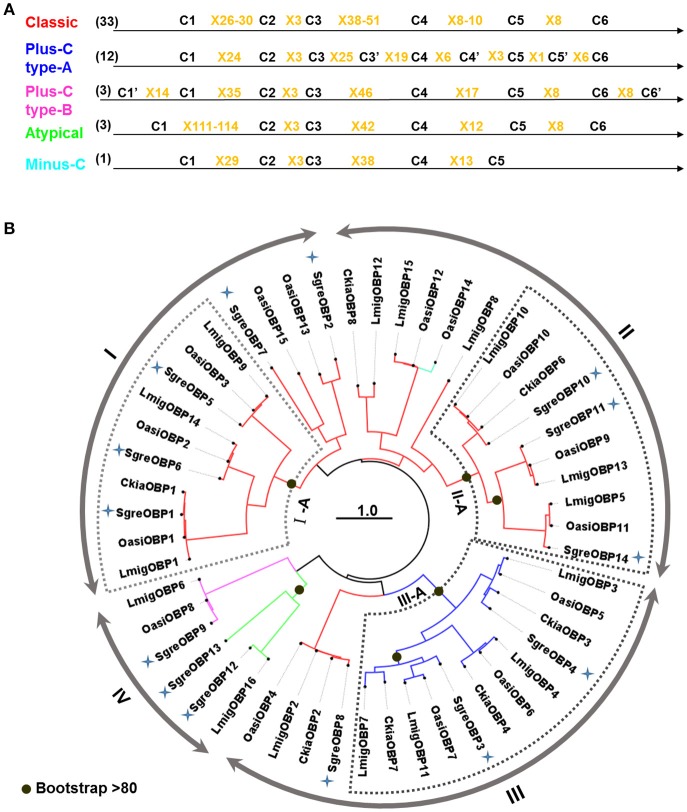
C-residue skeletons and phylogeny of OBPs from four locust species. (A) OBPs subtypes were categorized based on the number of conserved C-residues. C-skeleton patterns are based on the multiple sequence alignment of 52 OBP sequences from four locust species. C-residues conserved in all OBPs are shown as C1-C6 in black characters; additional C-residues conserved in the two plus-C OBP types are shown as C'; amino acid between two C-residues are shown as X plus the number of amino acid. The number of each OBP subtype is given in the parenthesis. (B) The phylogenetic tree was constructed using the maximum likelihood algorithm supported by 1,000 bootstrap replicates. OBP sequences utilized to generate the tree were derived from four locust species: 14 from Schistocerca gregaria (SgreOBPs), 16 from Locusta migratoria (LmigOBPs), 15 from Oedaleus asiaticus (OasiOBPs) and 7 from Ceracris kiangsu (CkiaOBPs). Four primary families (I-IV) are denoted by arrow lines. Further classification of three subfamilies (I-A, II-A, and III-A) was based on the over 80% bootstrap support at the internal node (indicated by black dots). Inner branches in different colors represent OBP subtypes in (A): red, classic OBPs; blue, plus-C OBPs type-A; magenta, plus-C OBPs type-B; green, atypical OBPs; cyan, minus-C OBP. Newly identified SgreOBPs are denoted by blue crosses. The tree is midpoint rooted. Scale bar represents one amino acid substitution per site.